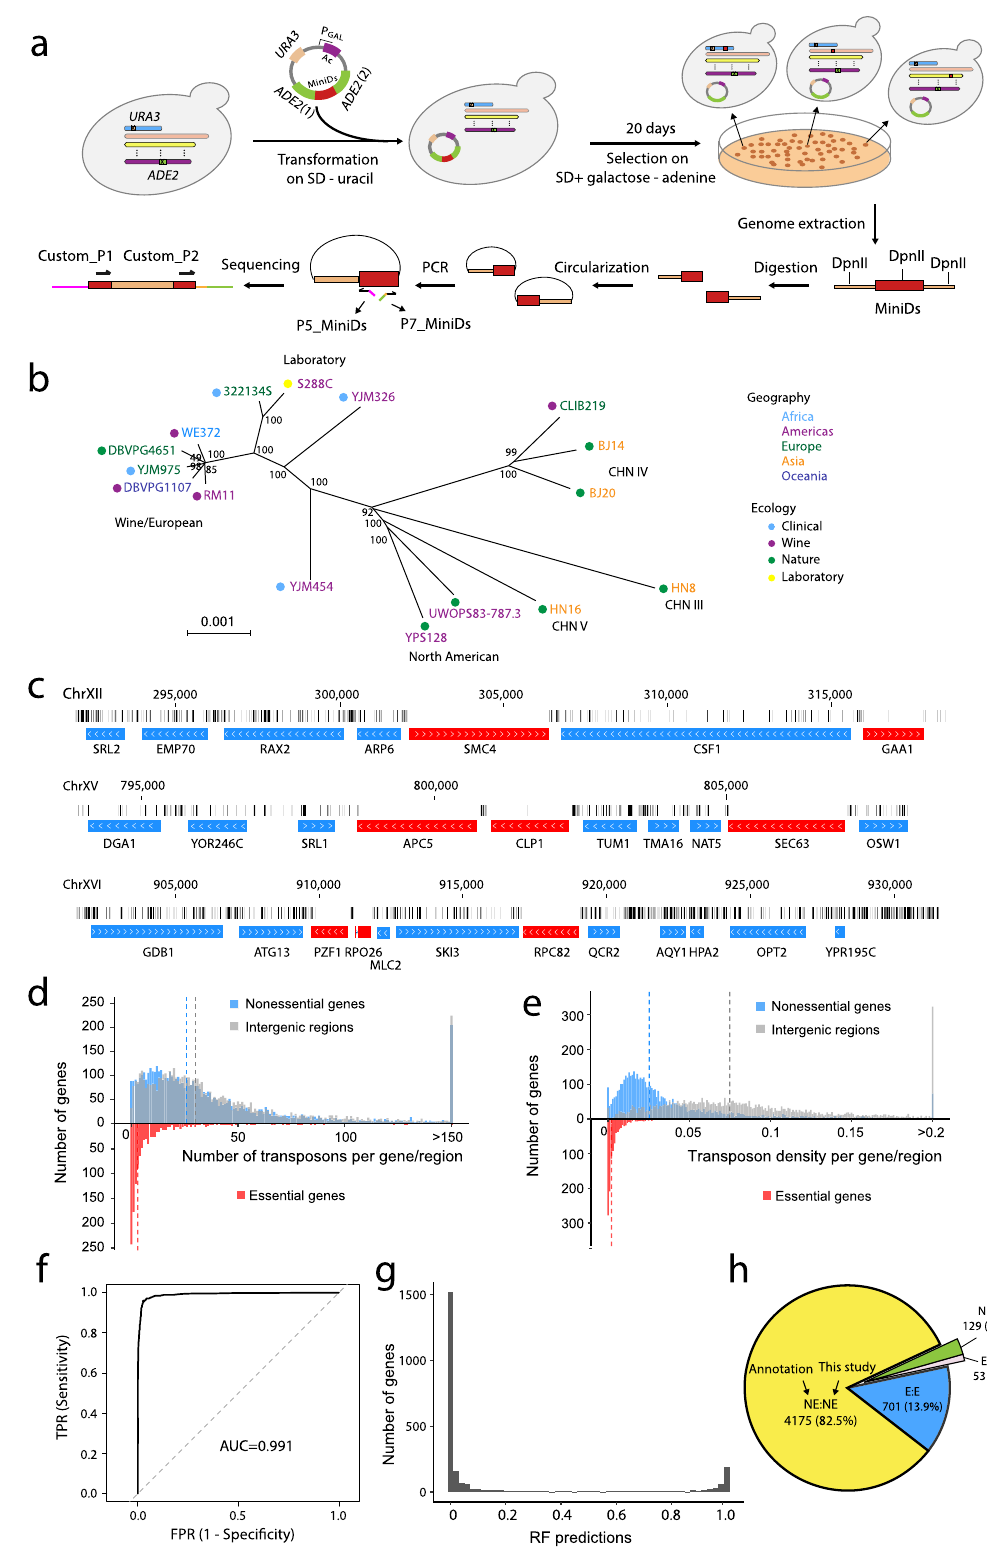
Our data from the strain S288C are generally consistent with annotations of essential and nonessential genes in the same strain that were based on individual heterozygous gene deletions followed by viability tests of haploid segregants 39 . The transposon map shows that the annotated nonessential genes are highly tolerant to transposons while essential genes are largely (but not